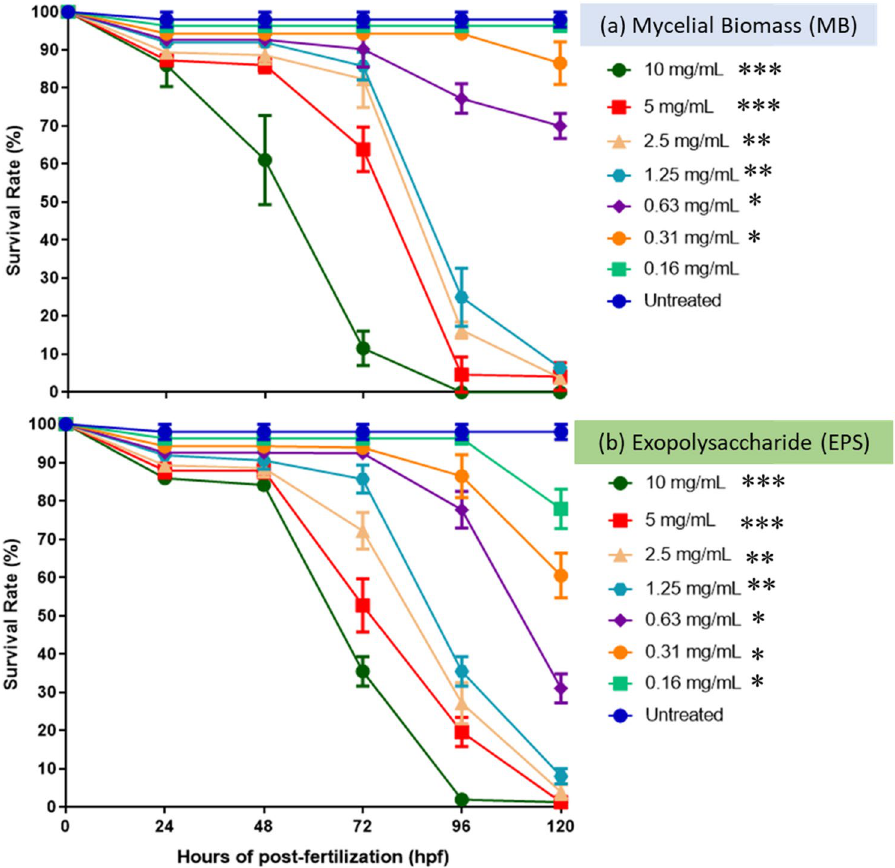
Figure 1. The performance of Tiger milk mushroom, Lignosus rhinocerus strain ABI ( a ) MB and ( b ) EPS extract at concentrations of 0.16–10 mg/mL on the survival rate of zebrafish embryos at 0–120 h. Symbols: *** p < 0.001, ** p < 0.01 and * p < 0.05. No embryos survived for both samples at concentration tested > 5.0 mg/mL after 96 h-post-fertilization